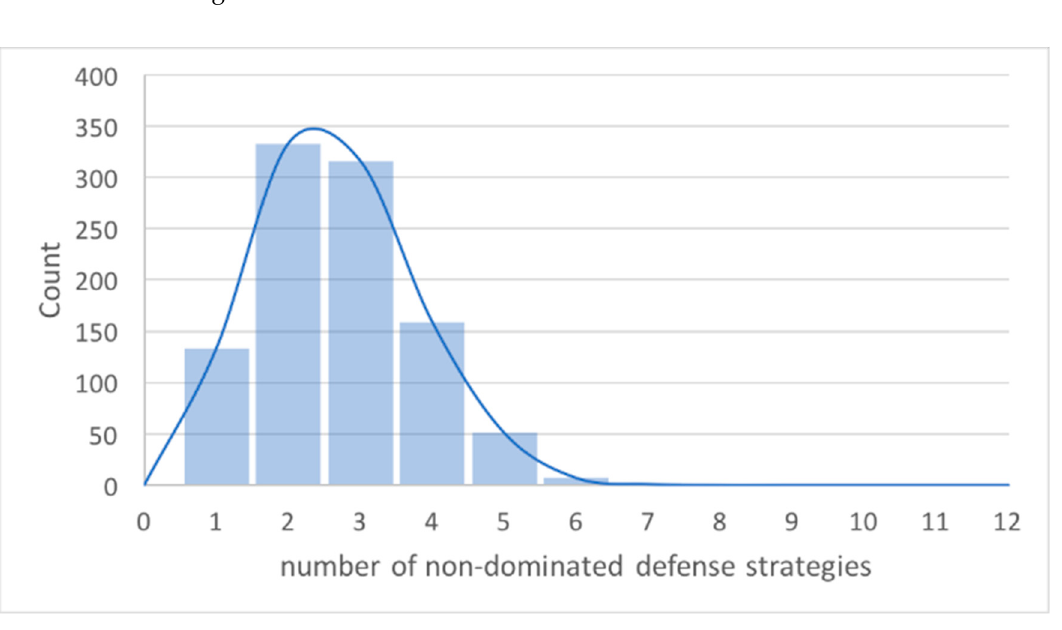
Figure 11. Histogram for difference between Pareto-defense and Nash Equilibrium strategies.